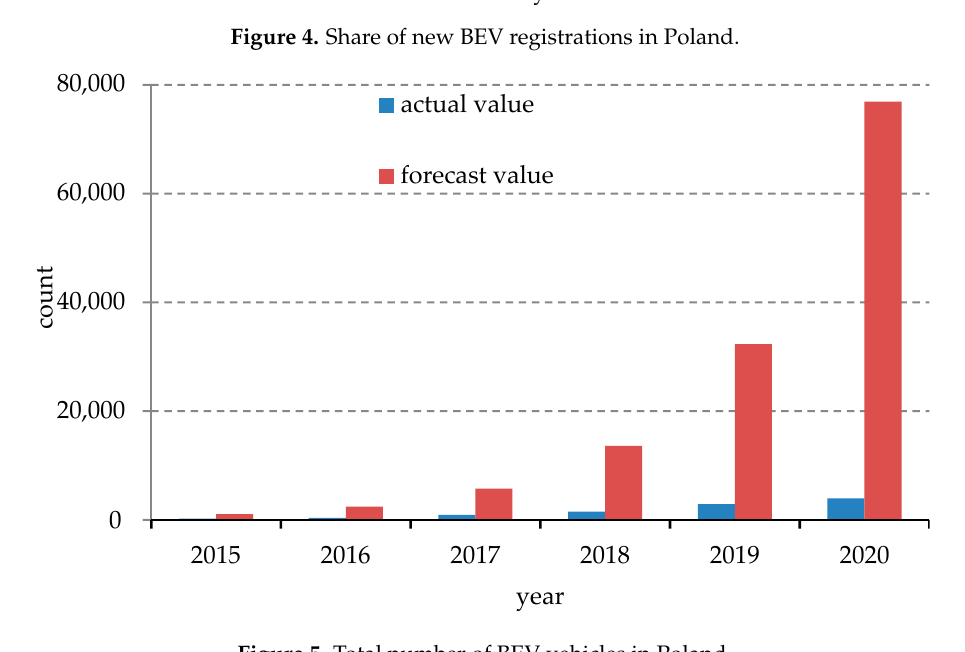
Figure 5. Total number of BEV vehicles in Poland.